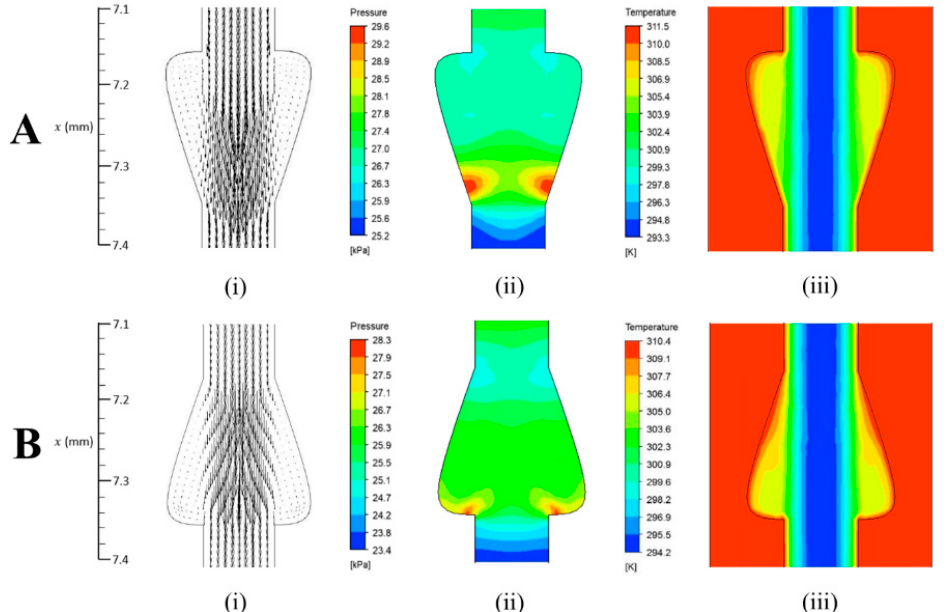
Figure 12. ( i ) velocity vectors, ( ii ) pressure contour and ( iii ) temperature contour for the microchannel with parameters at ( A ), β = 0.5, γ = 2.0 and δ = 0.15 and at ( B ), β = 0.5, γ = 2.0 and δ = 0.85.